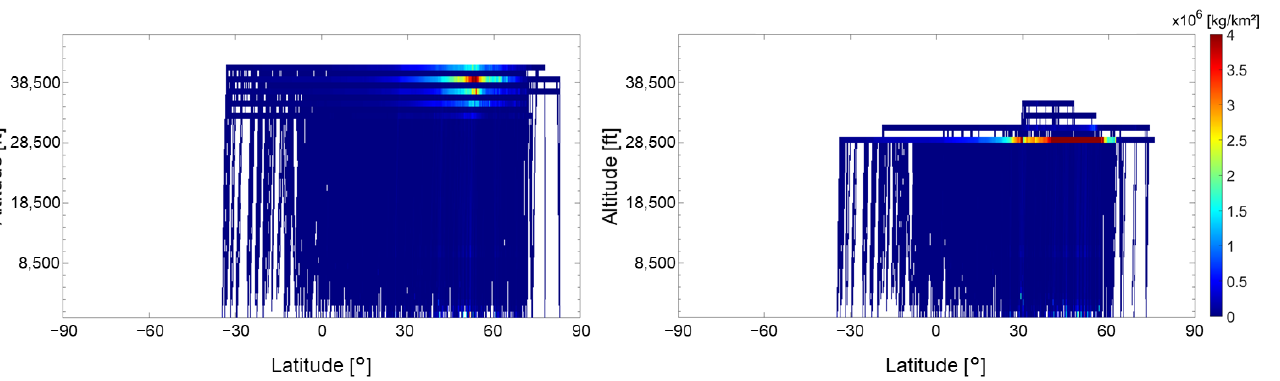
Figure 6. Zonal and vertical distribution of CO 2 emissions with fuel-optimised ISO ( left ) and climate- optimised ISO ( right